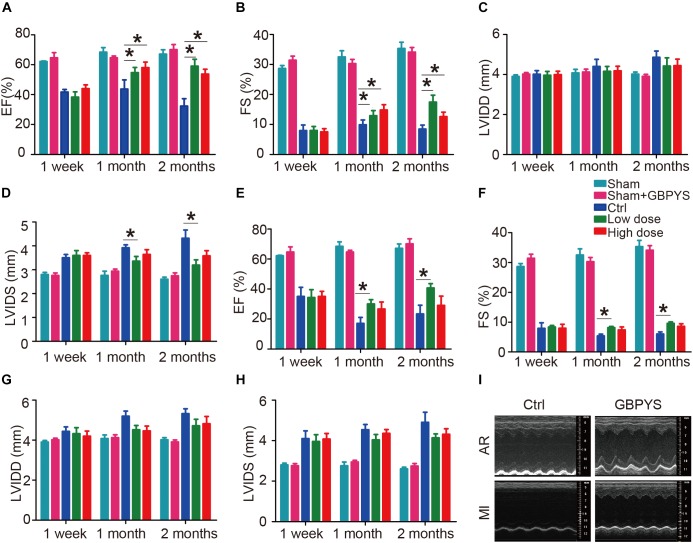
GBPYS feeding improved cardiac function after myocardial damages. (A–D) Evaluating treatment effect of GBPYS feeding on apical resection. Compared to control feeding (Ctrl), GBPYS feeding improved cardiac function in mice with apical resection (n = 6 each for Ctrl and GBPYS feeding). Left ventricular ejection fraction (LVEF; A) and left ventricular fractional shortening (LVFS; B) were significantly improved at 1 and 2 months of both low-dose and high-dose GBPYS feeding. Left ventricular systolic inner diameter (LVIDs; D) were reduced at 1 and 2 months of low-dose GBPYS feeding. (E–H) Evaluating treatment effect of GBPYS feeding on MI. Compared to control feeding, GBPYS feeding improved cardiac function in mice with MI. LVEF (E) and LVFS (F) were improved in low-dose GBPYS feeding group at 1 and 2 months of feeding. (I) Representative echocardiographic images showing improvement in cardiac function after GBPYS feeding in mice with apical resection or MI. One-way ANOVA. ∗P < 0.05.